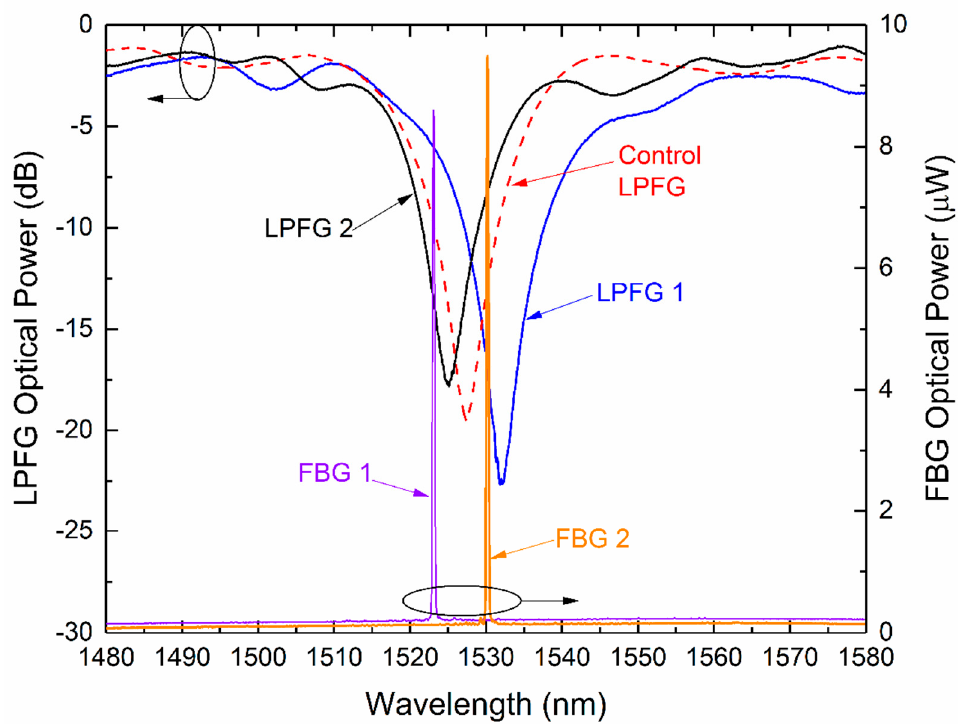
Figure 1. Spectra of the gratings in air at 35 °C: Long Period Fiber Grating (LPFG)1, LPFG2, and Control LPFG measured in transmission mode. Fiber Bragg Grating (FBG)1 and FBG2 measured in reflection mode.